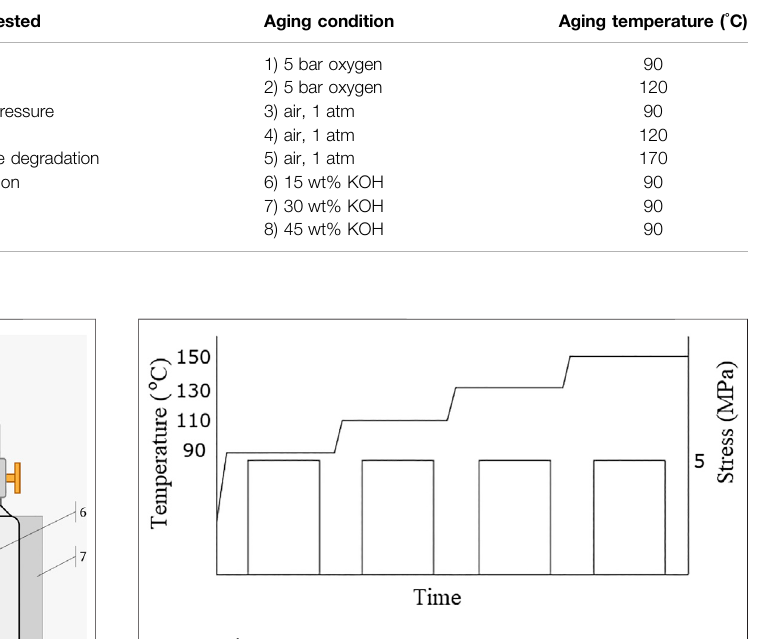
FIGURE 4 | Sequence of loadings and unloadings in the creep-recovery test.Theschedulestartswithaholdat90 ° Cfor15 min.,acreepmeasurement at 5 MPa for 60 min., followed by a temperature increase, equilibration and recovery of 15 min., then again a creep test at 5 MPa for 60 min and so